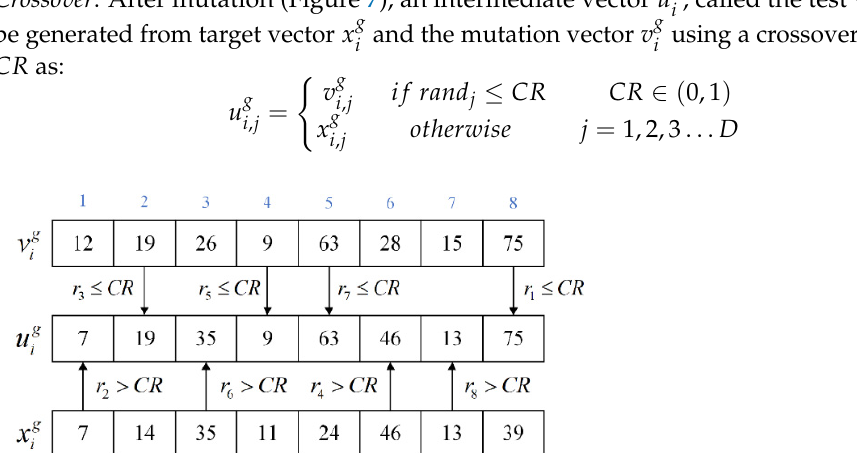
Figure 7. The process of crossover operation.